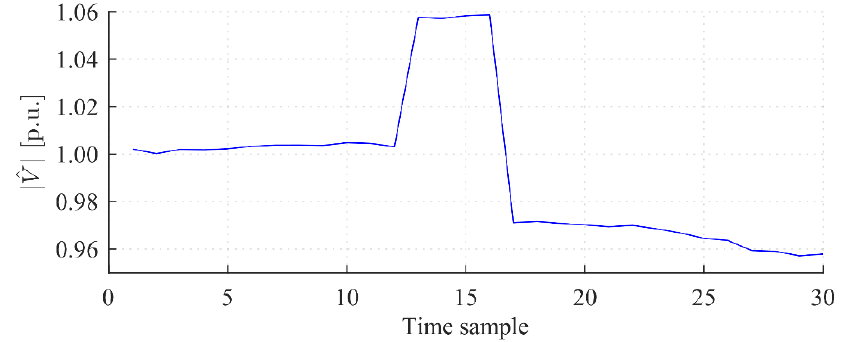
Figure 6. MV/LV transformer secondary busbar voltage (mean) — case 3.